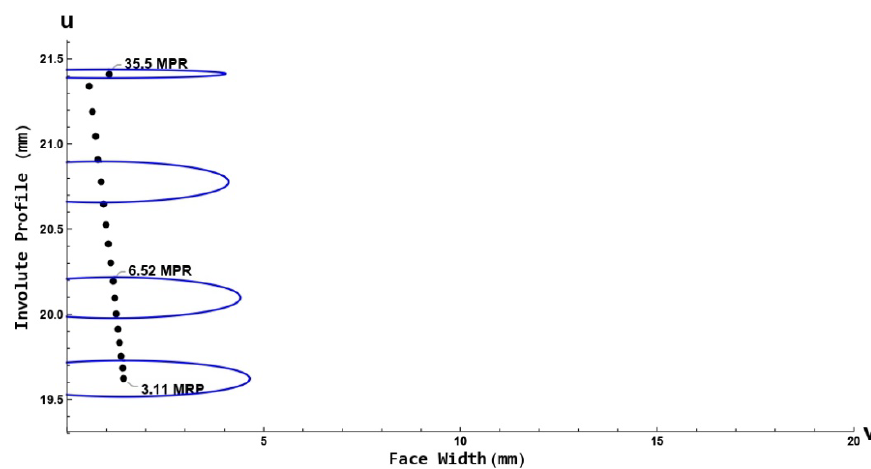
Figure 25. The MPR of crowned helical gears with a minimum amount of circular and tip relief for an out-of-plane misalignment of 0.2° (3.5 mrad), with the location of contact ellipse at the contact point.